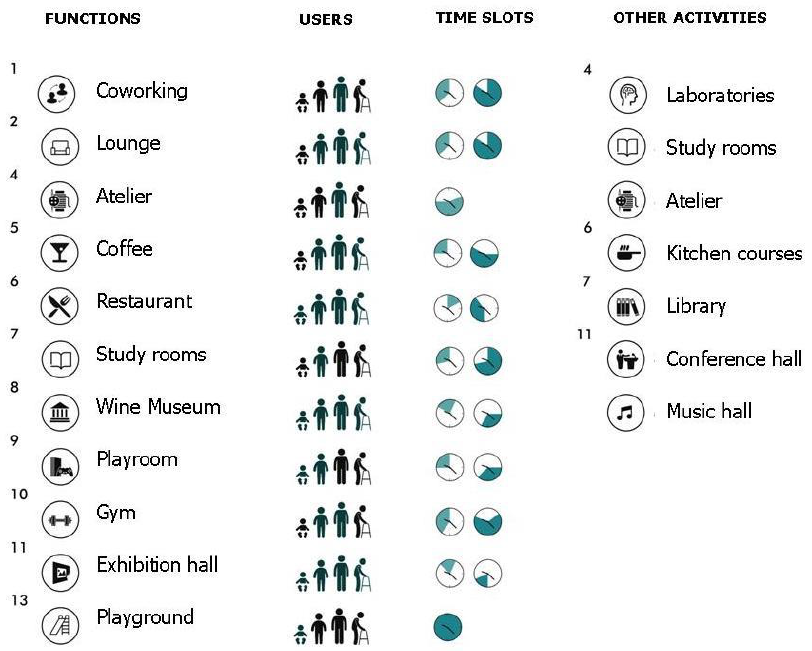
Figure 8. New functions and further activities in relationship whit the user’s needs